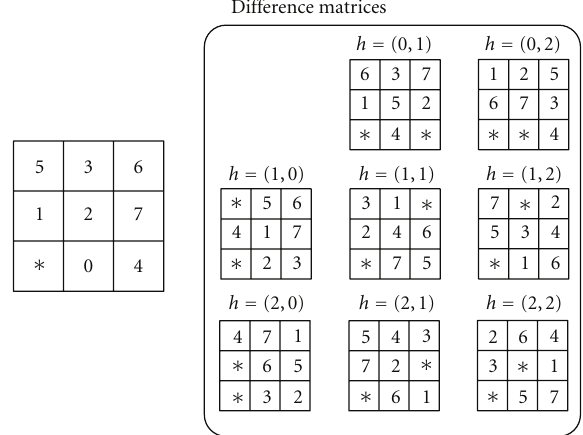
Figure 2: A Z 3 × Z 3 MPCA and its di ff erence matrices. The ∗ in the MPCA symbolizes that the mapping for (0,0) is not defined, that